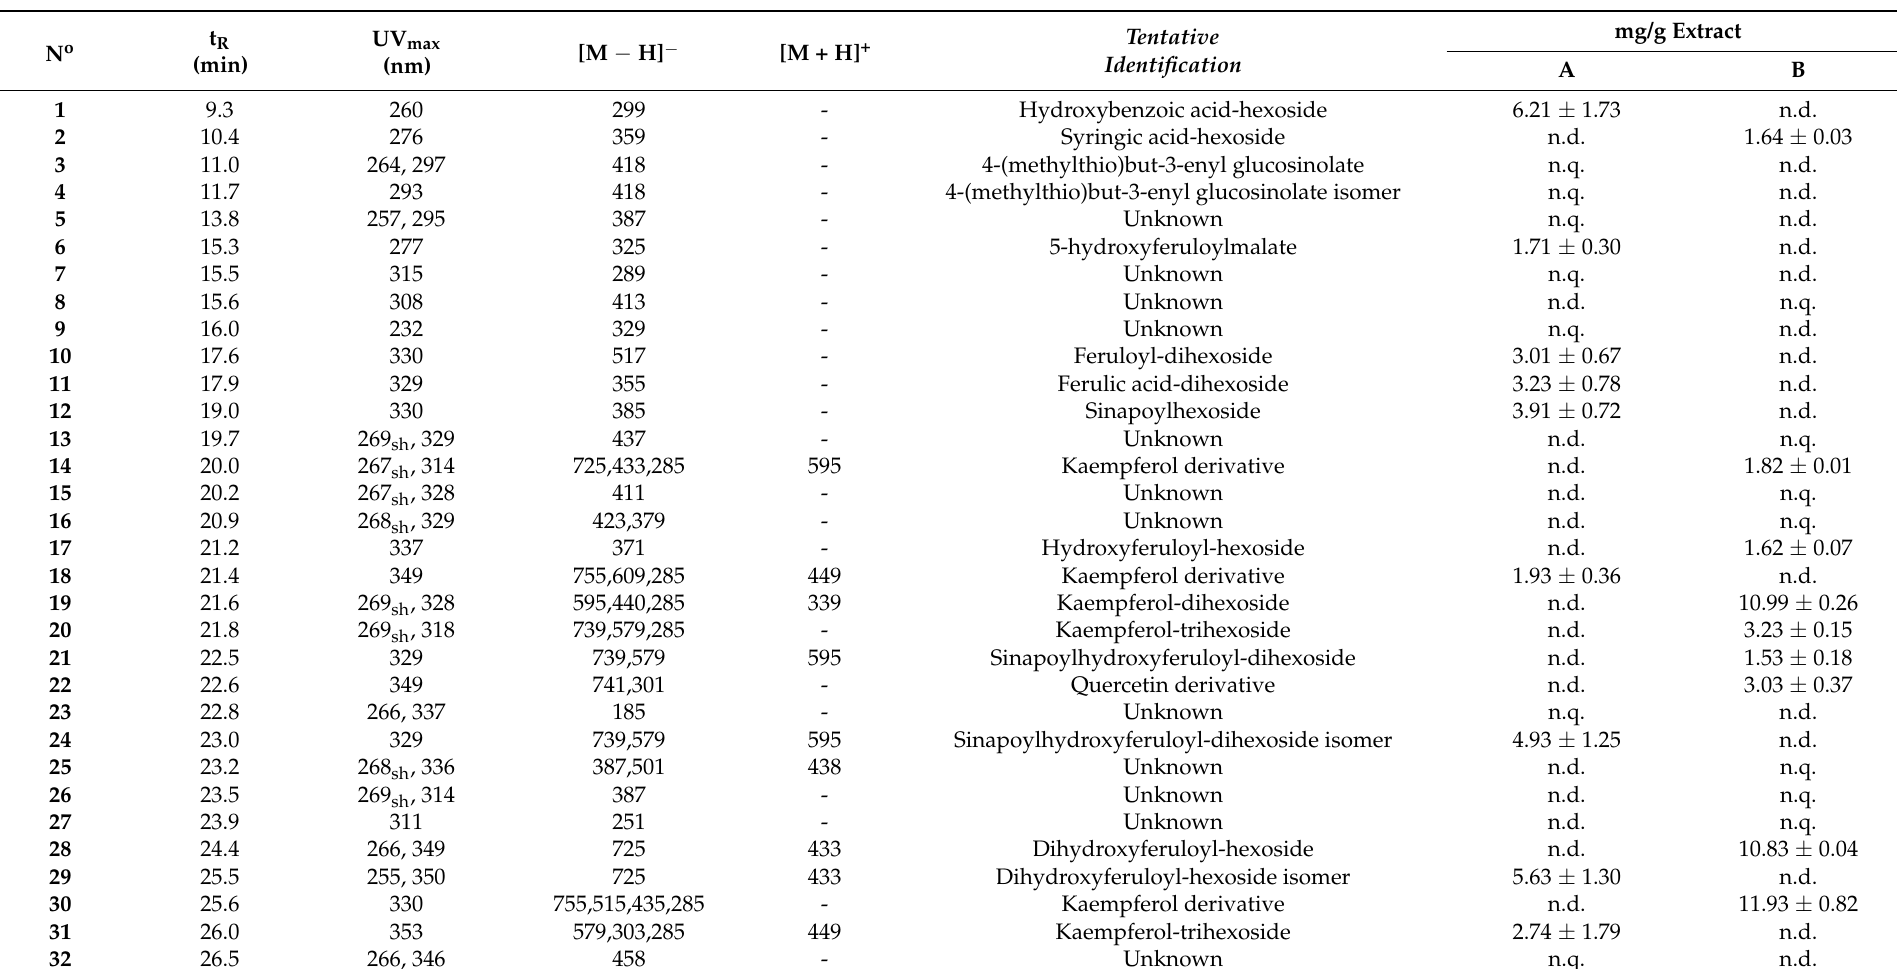
Table 1. HPLC–PDA/ESI–MS (negative and positive ionization modes) polyphenolic fingerprint of M. fruticulosa subsp. fruticulosa ( A ) and subsp. coronopifolia ( B ) extracts. Results are expressed as mg/g extract ± S.D. ( n =